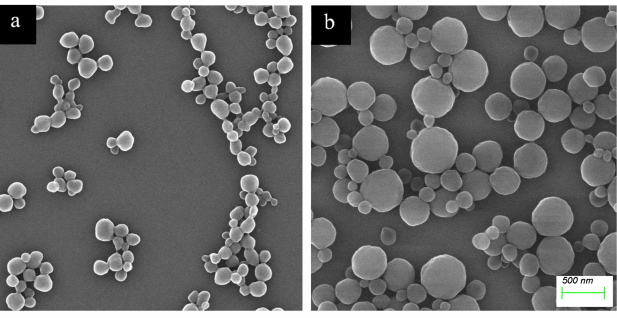
Figure 4. SEM photographs of ( a ) haa-MIP and ( b ) NIP